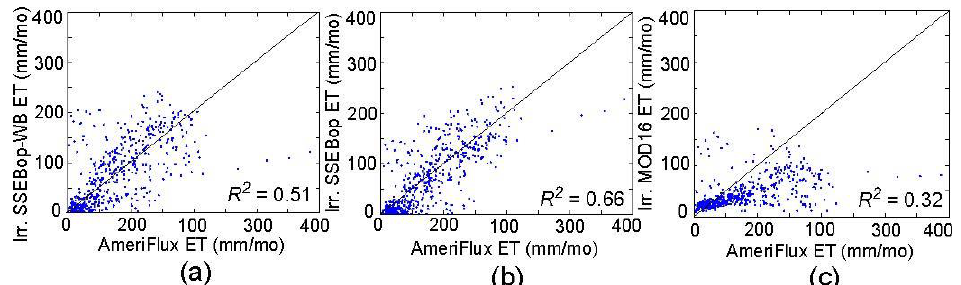
Figure 5. Comparisons of AmeriFlux data with the ET predictions only in tower locations where the MIrAD-US product (Figure 2) indicated active irrigation, for ( a ) scaled SSEBop; ( b ) SSEBop; and ( c ) MOD16.